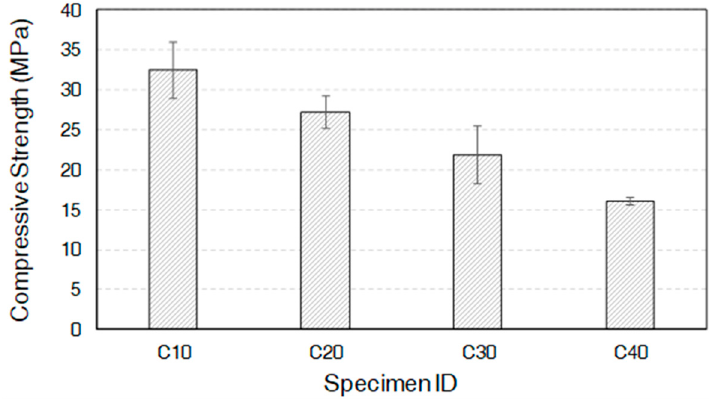
Figure 7. Unconfined compressive strength of the mixtures of slag and CCR.